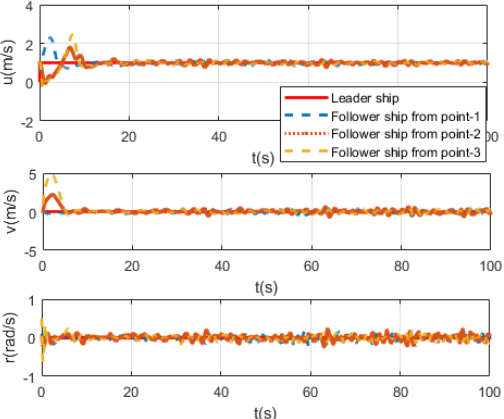
Figure 3. The synchronization of velocities from disparate initial points with disturbances.